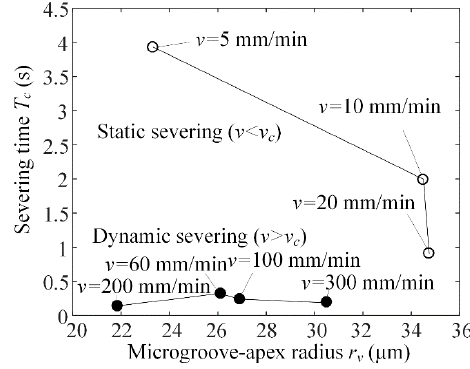
Figure 10. Severing time T c versus microgroove-apex radius r v .